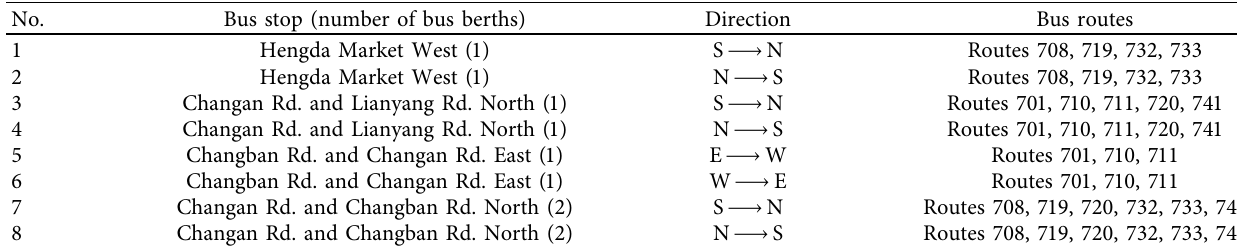
Figure 1: Locations of eight bus stops for AVL data Table 1: The details of test bus stops.